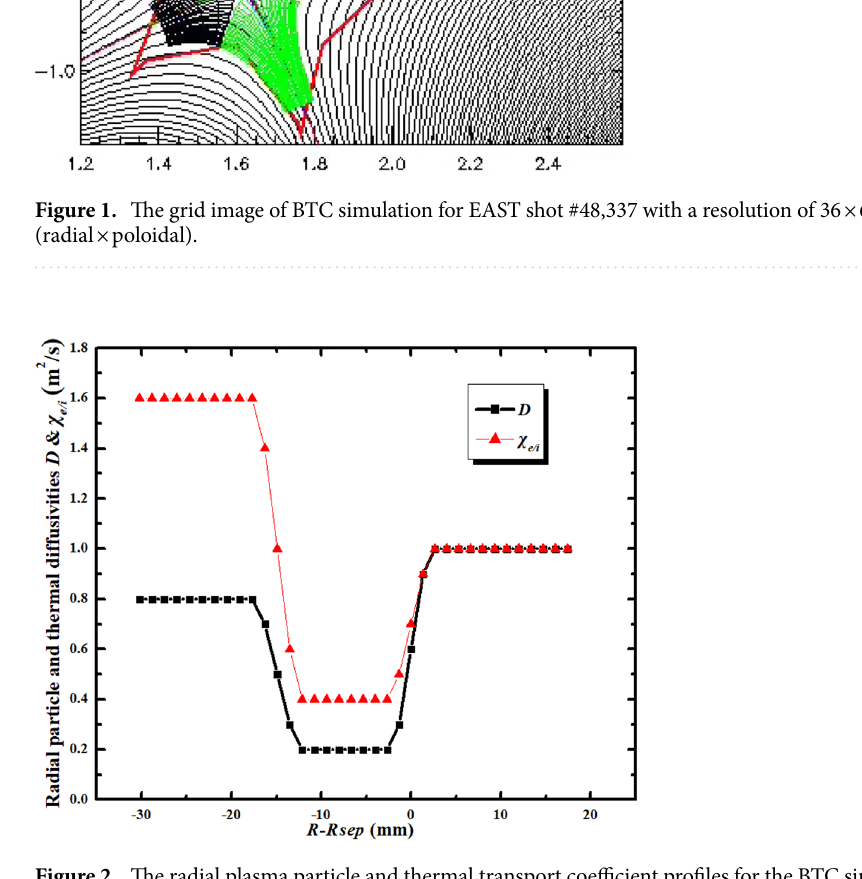
Figure 2. The radial plasma particle and thermal transport coefficient profiles for the BTC simulations of EAST discharge